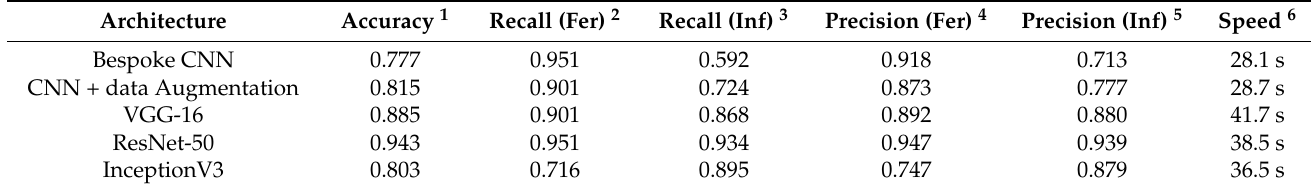
Table 2. Performance of transfer learning architectures against the test set.